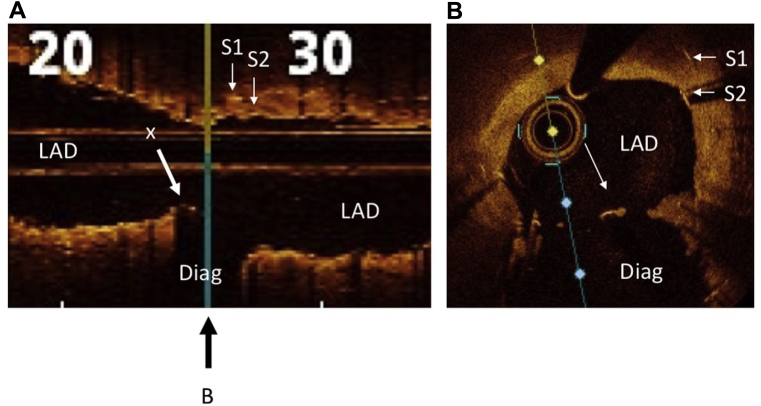
Optical coherence tomography of case 7 after double-kissing nanocrush stent deployment to the left anterior descending coronary artery (LAD) and diagonal (Diag). (A) Longitudinal section through the LAD, showing origin of stented diagonal branch. X indicates the neocarina; the black arrow below the figure indicates the position of cross-section shown in B. S1 and S2 are the original and new main branch stents, respectively. (B) Cross-section at the level of the neocarina (X). This example was originally a severe case of 1,1,1 bifurcation in-stent restenosis in a stent placed with the use of a provisional technique across the diagonal branch, which explains the double strut layer in the LAD.